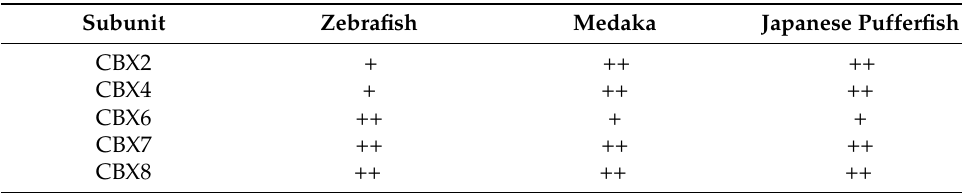
Table 3. The genes coding for the CBX subunits of the cPRC1 complex in zebrafish ( Danio rerio ), medaka ( Oryzia latipes ) and Japanese pufferfish ( Tetraodon nigroviridis ). Subunit Zebrafish Medaka Japanese Pufferfish CBX2 CBX4 CBX6 CBX7